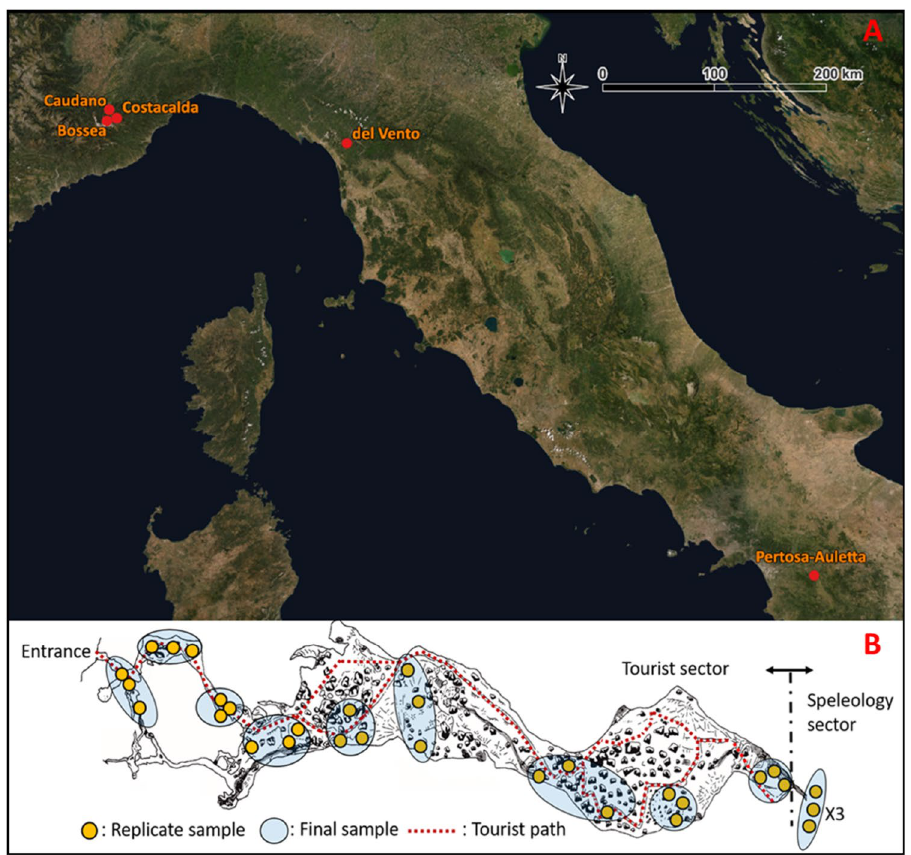
Figure 8. Geographic map of Italy with locations of caves surveyed ( A ) and schematic overview of sampling method applied ( B ). Images were produced mapping the caves’ coordinates layer by qGIS 3.22 45 on a WMS version of ESRI World Imagery map (https:// server. arcgi sonli ne. com/ ArcGIS/ rest/ servi ces/ World_ Image ry/ MapSe rver/ tile/ {z}/ {y}/